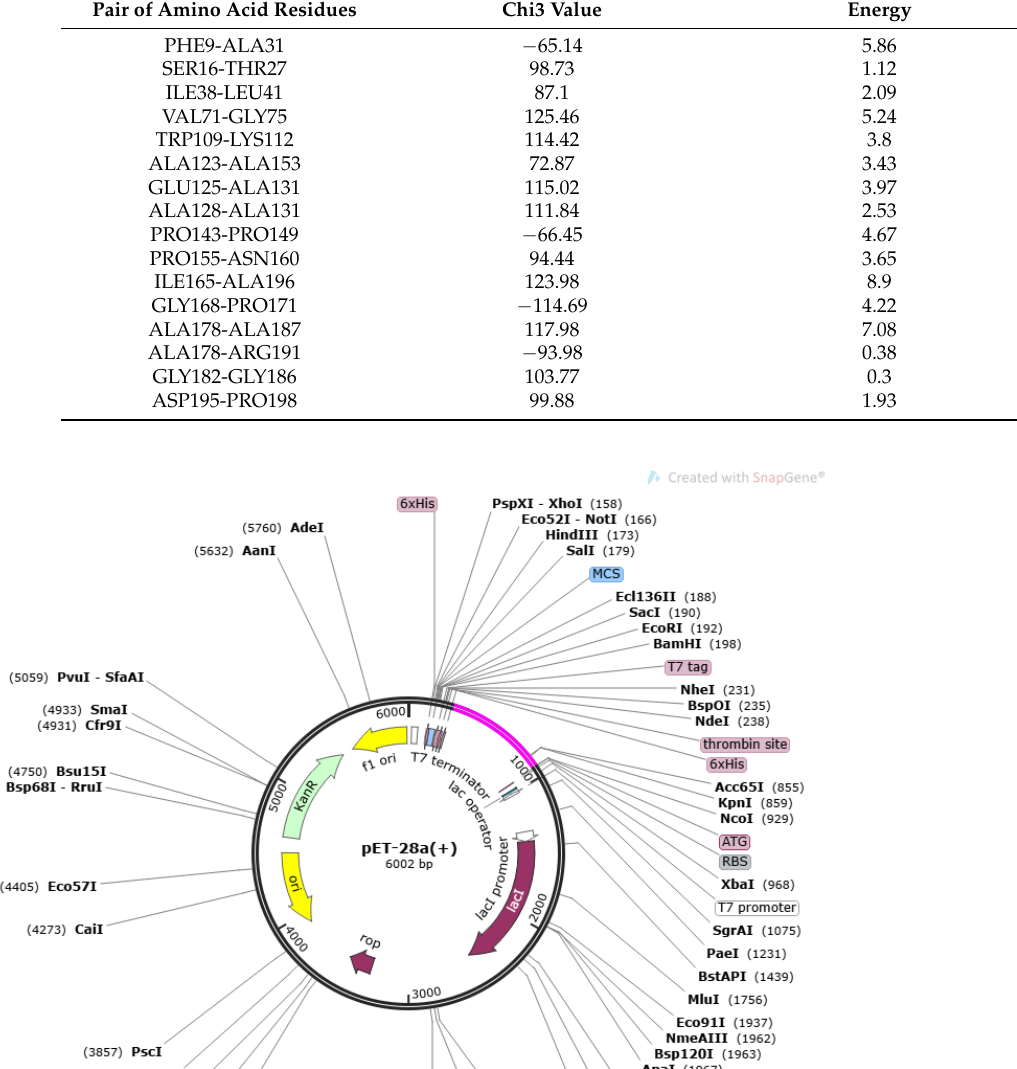
Figure 9A. Secondary structure of the multi-epitope-vaccine construct revealed that 84